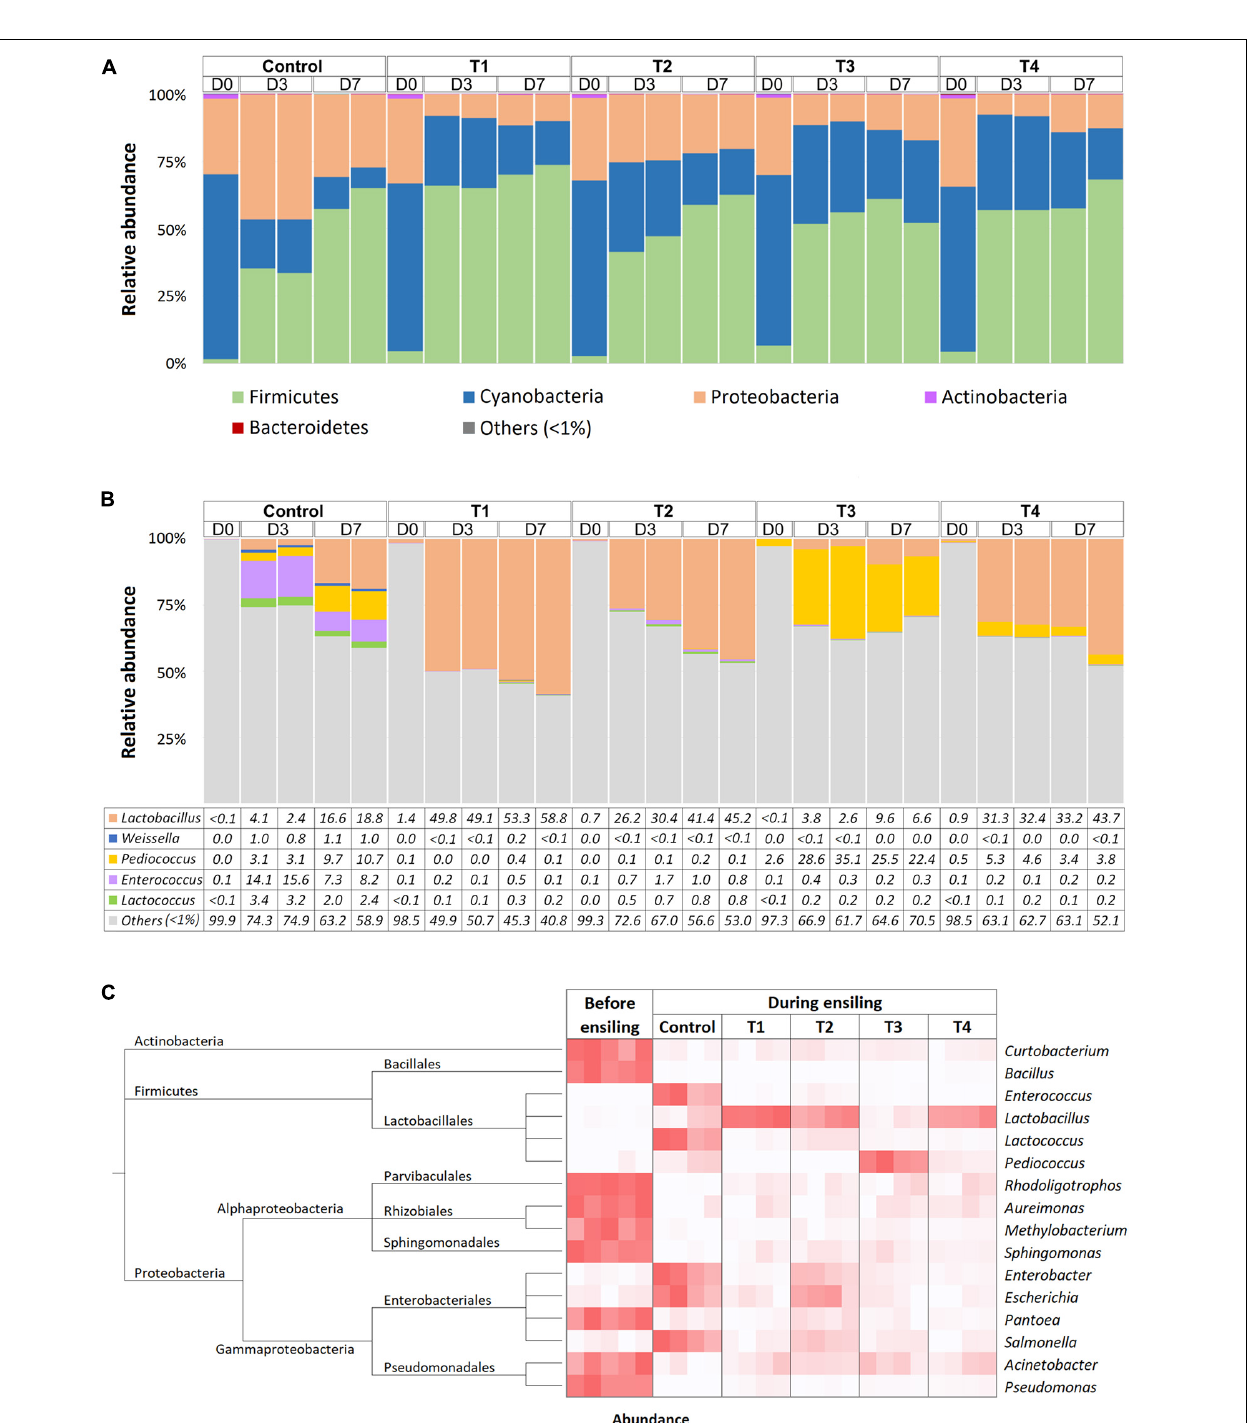
FIGURE 2 | Bacterial profiles of Napier grass silage in five treatment groups, which were a non-inoculated control group (control), and the groups inoculated with following starter inocula, Lactobacillus plantarum J39 (T1), L. brevis BCC42336 (T2), Pediococcus pentosaceus TBRC7603 (T3), and a combination of L. plantarum J39, L. brevis BCC42336, and P. pentosaceus TBRC7603 (T4). Silage was sampling on Day 0 (D0), Day 3 (D3), and Day 7 (D7) of ensiling. (A) Relative abundance of bacterial phyla. (B) Relative abundance of lactic acid producing bacteria genera. (C) Differences in bacterial profiles identified by Kruskal-Wallis H -test at ASV level. Taxonomic tree and heatmaps of microbiota based on the results of the comparison between treatment and control at D3 and D7 in Napier grass silages. The heatmaps show representative ASVs with an adjusted p -value < 0.05.